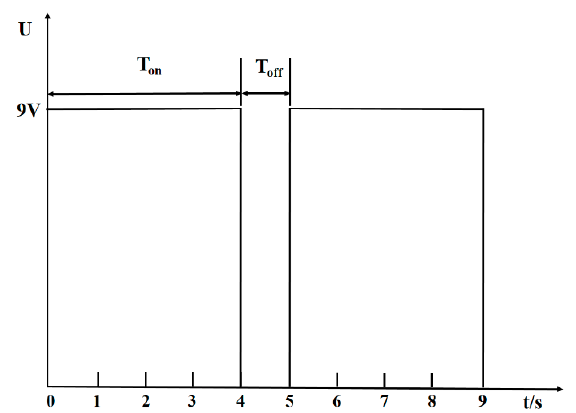
Figure 3. Schematic diagram of the pulsed electric field (PEF) pattern. U: constant voltage, T on = 4 s, T off = 1 s.